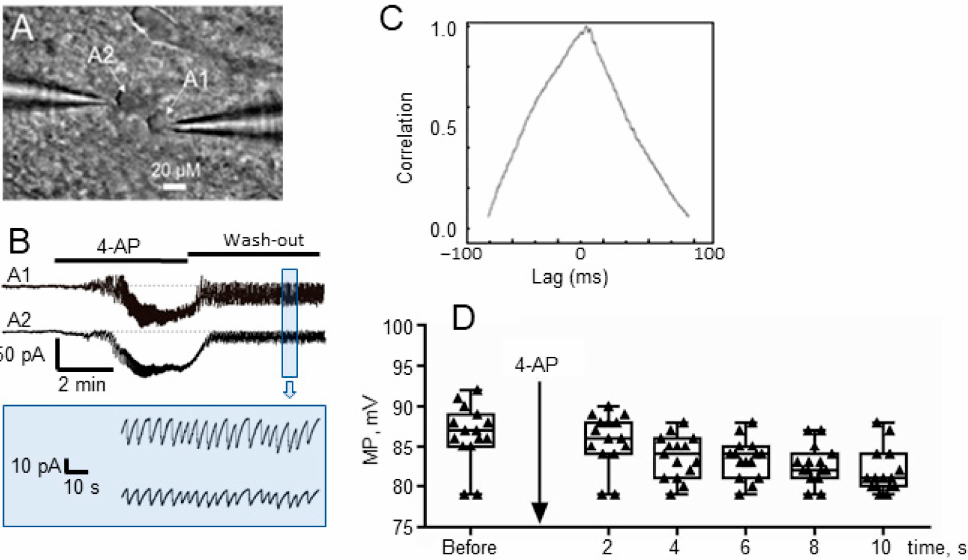
Figure 2. ( A ) Two astrocytes, A1 and A2, with microelectrodes attached. ( B ) Recording of the astrocyte currents. Simultaneous high-amplitude inward currents and high-frequency activity in the astrocytes shown in ( A ) after application of 4-AP and washout. ( C ) Cross correlation function (CCF) graph of recordings in ( B ) with a value of 0.98 at lag time = 0. ( D ) E ff ects of 4-AP application on astrocytes MP, before and during 10 min after 4-AP application (data shown are mean M ± standard error of mean, SEM, and